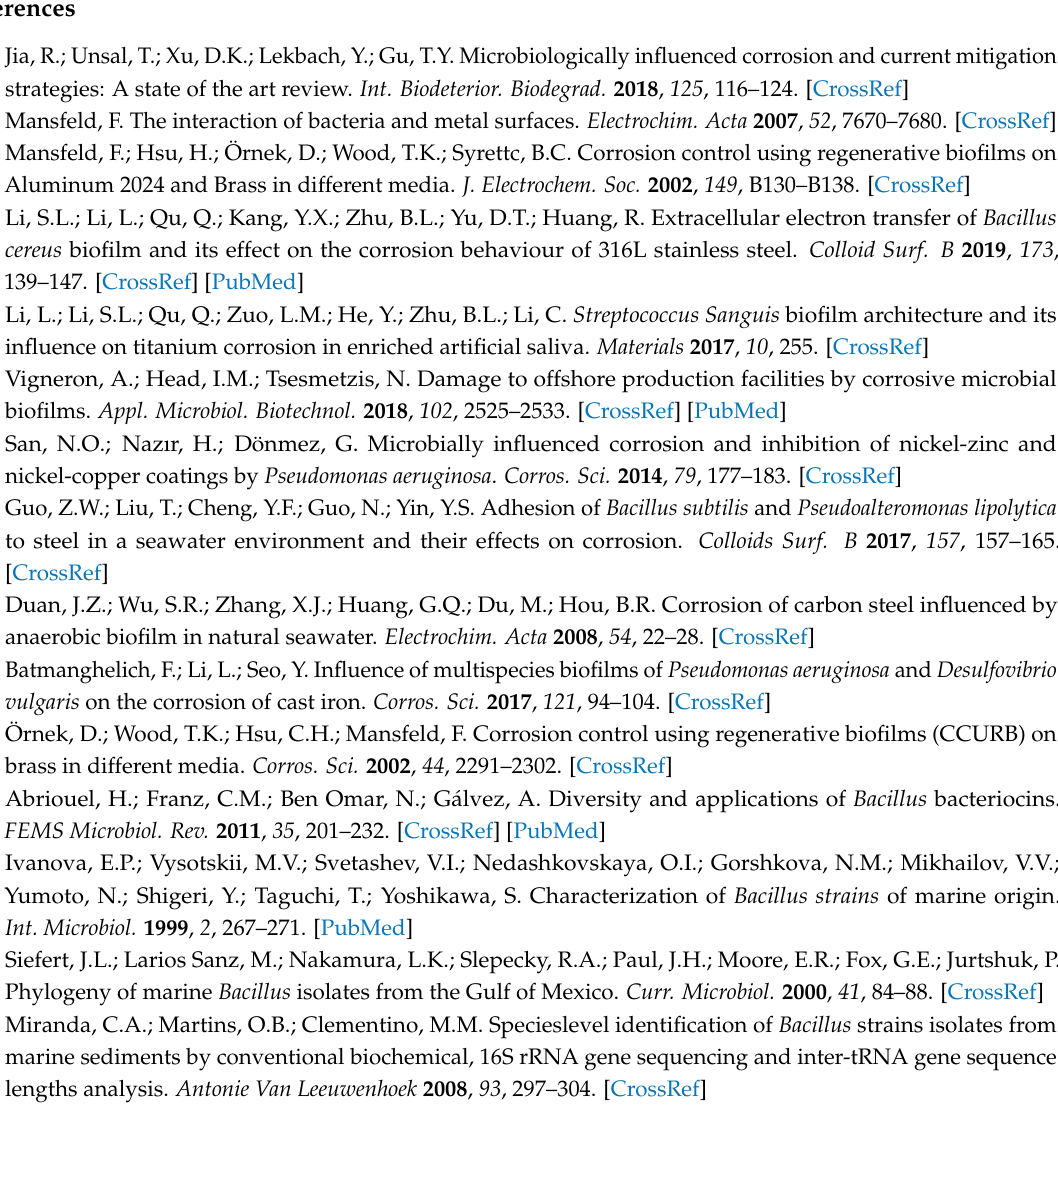
Figure S1. SEM images of AZ31B magnesium alloy specimens before and after electrochemical measurement in the control group (before: A, after: B) and the B. subtilis presence group (before: C, after: D) at 48 h. (high voltage: 20 kV). Table S1. Elemental compositions (wt %) of the surface of AZ31B magnesium alloy specimens before and after electrochemical measurement in the control group and the B. subtilis presence